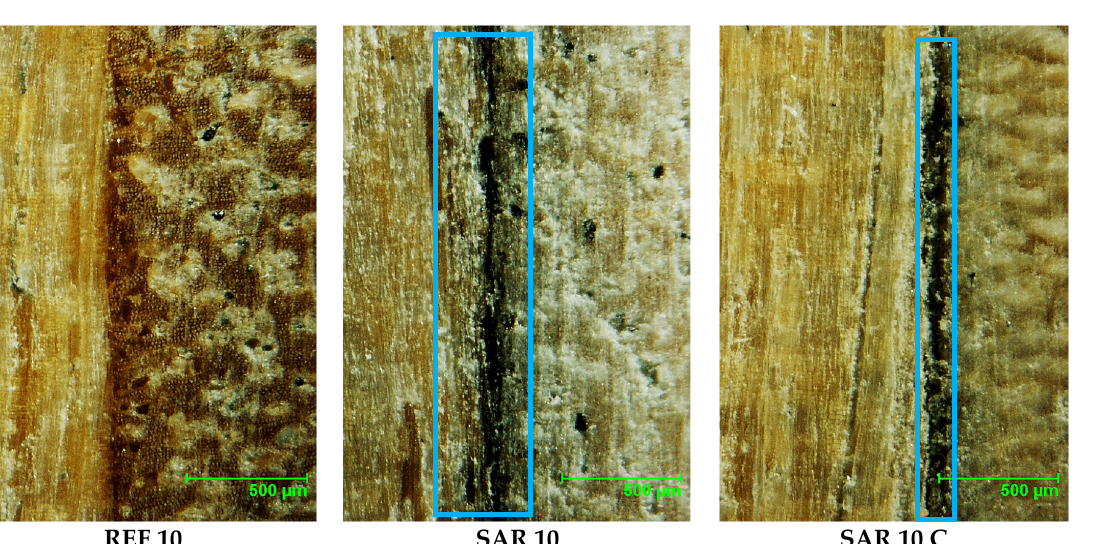
Figure 10. The density profiles of the plywood samples of different SAR filler content, cold-pressed.